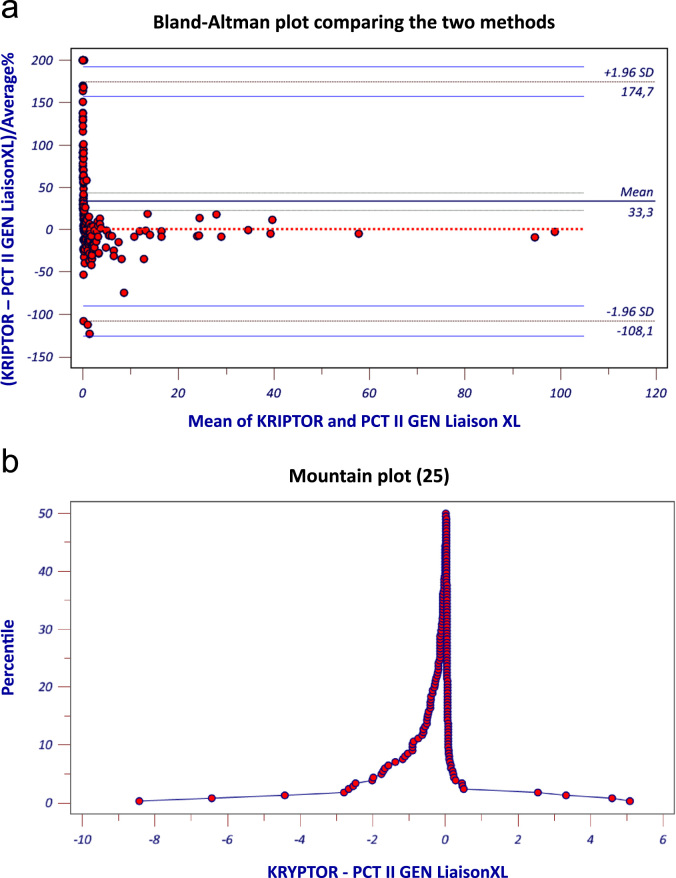
(a) Bland-Altman plot comparing the two methods; and (b) mountain plot [25].